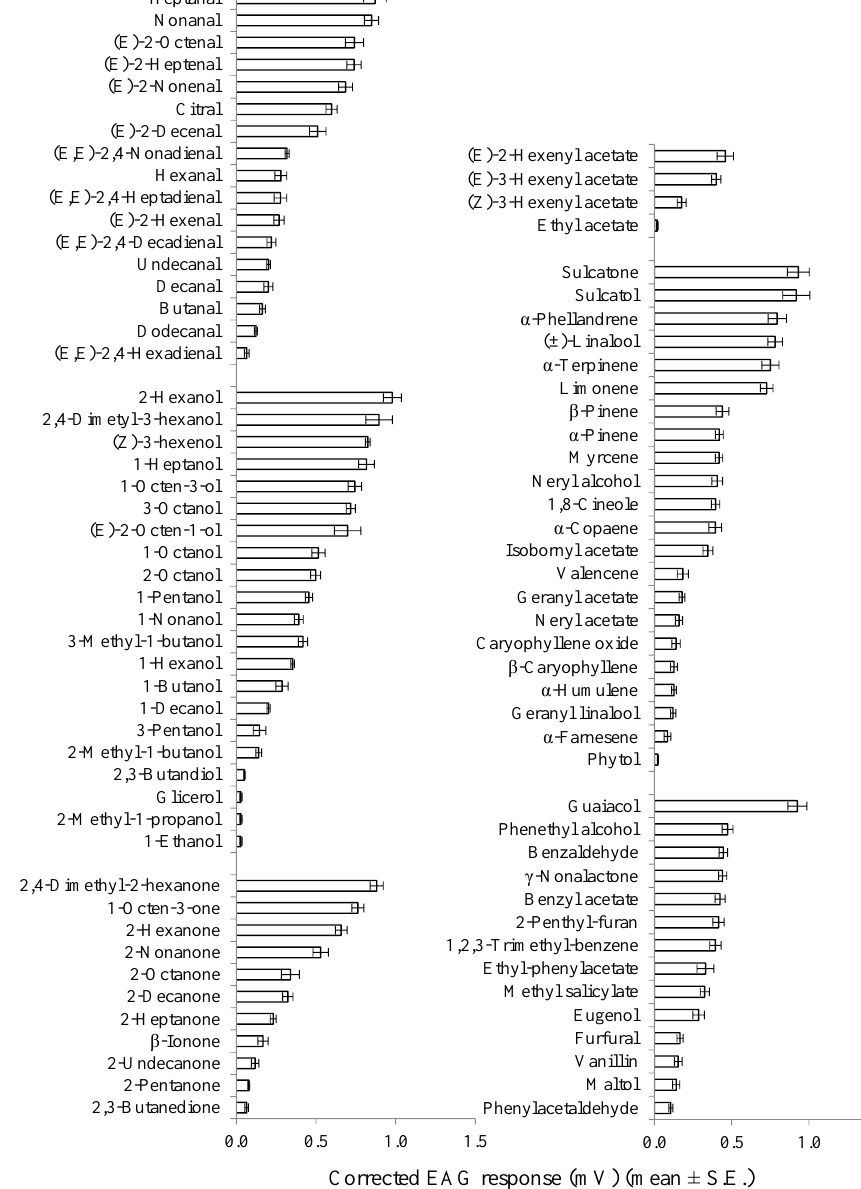
Figure 4. EAG response profile of female A. bungii distal flagellomeres (seventh to ninth) to a range of VOCs. Within each chemical group, compounds are listed according to the mean amplitude of the EAG response (n = 5) elicited at the 1 mg dose.